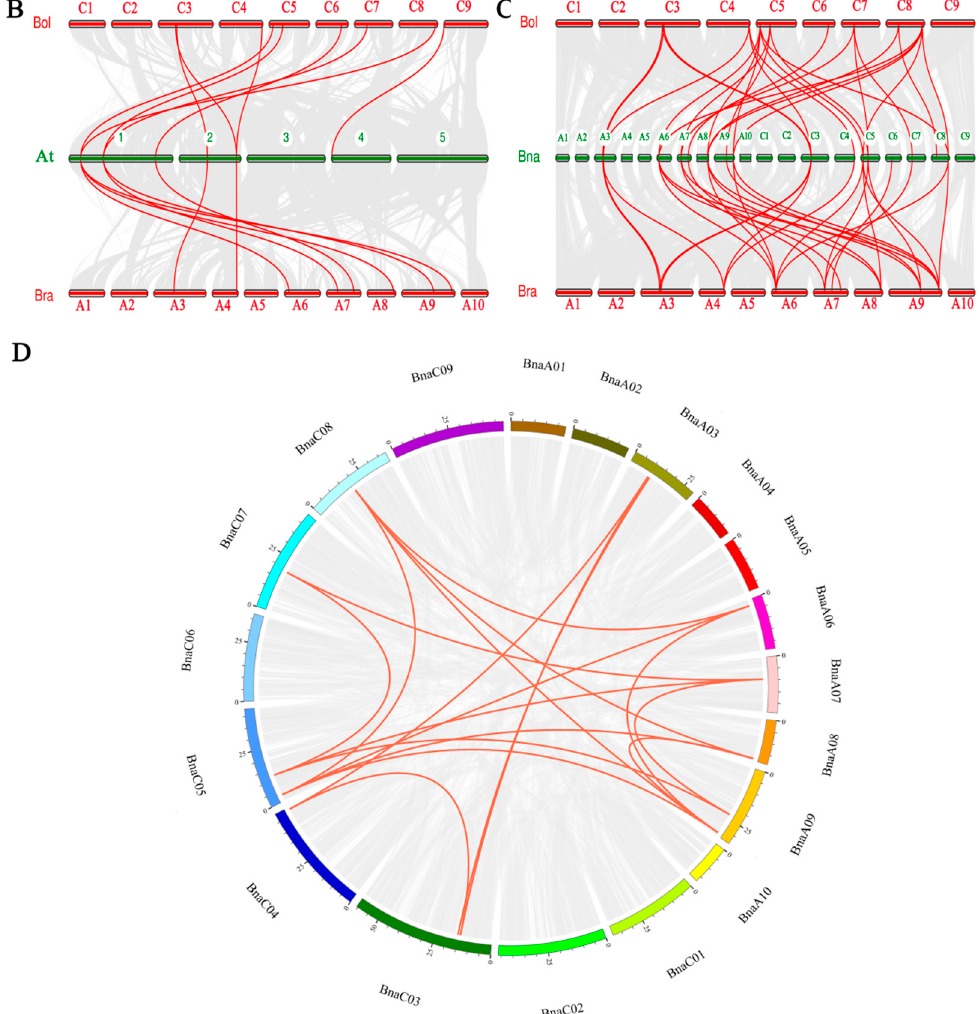
Figure 2. Chromosomal locations of BnaYAB genes in the B. napus genome and syntenic analysis of YABBY genes in Arabidopsis, B. napus , B. rapa , and B. oleracea . ( A ) Chromosomal location of the 21 BnaYAB genes in the B. napus genome. Genes from the same subgroup are highlighted in the same color, as defined in the phylogenetic tree (Figure 1). Each chromosome is drawn as a heatmap of gene density. ( B ) Collinearity analysis of YABBY family genes between Arabidopsis, B. rapa , and B. oleracea , indicated as connecting lines. ( C ) Collinearity analysis of YABBY family genes between B. napus , B. rapa , and B. oleracea , indicated as connecting lines. ( D ) Chromosomal locations of the 21 BnaYAB genes in the B. napus genome, indicated as connecting lines. A and C denote the two main subgenomes in B. napus . Mb, megabase; Ann, pseudomolecule chromosomes. The 5 Arabidopsis chromosomes (1–5), 19 B. napus chromosomes (A01–A10 and